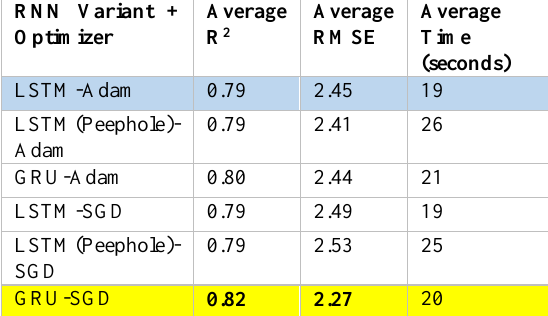
Table 3. Comparison between different RNN variants and